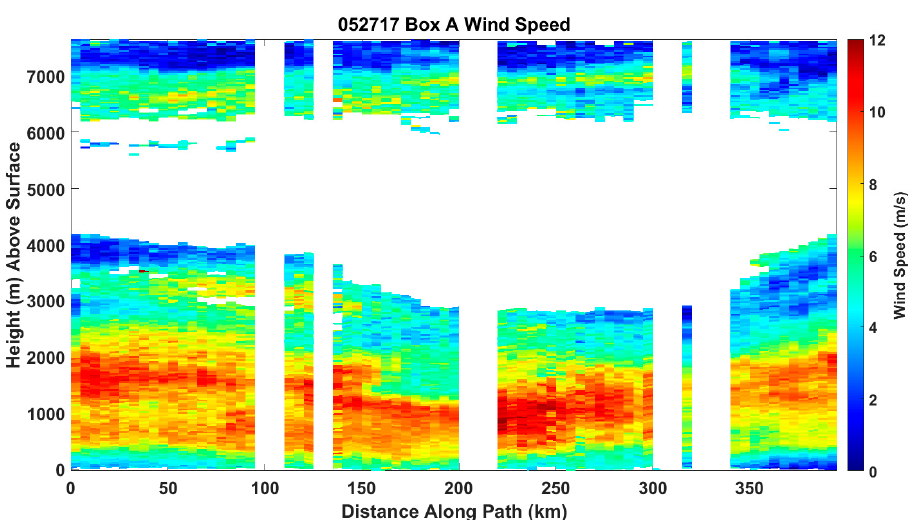
Figure 14. Curtain of DAWN wind speed profiles around Box A between 200005Z and 205006Z on 27 May 2017.